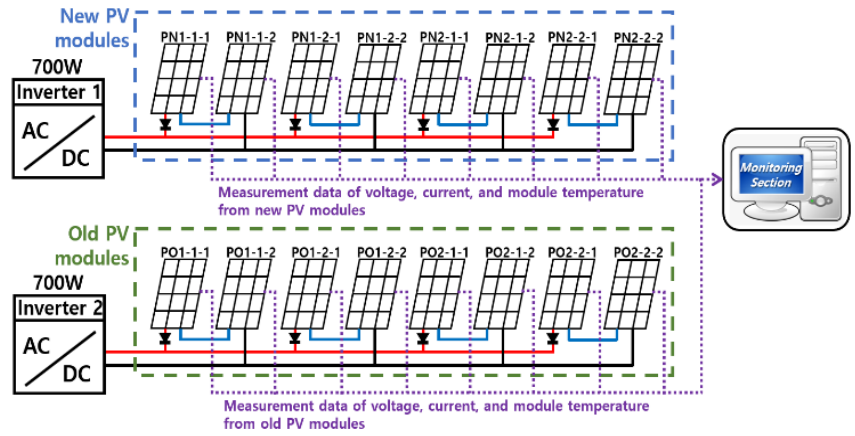
Figure 3. Configuration of the entire system of the test device.